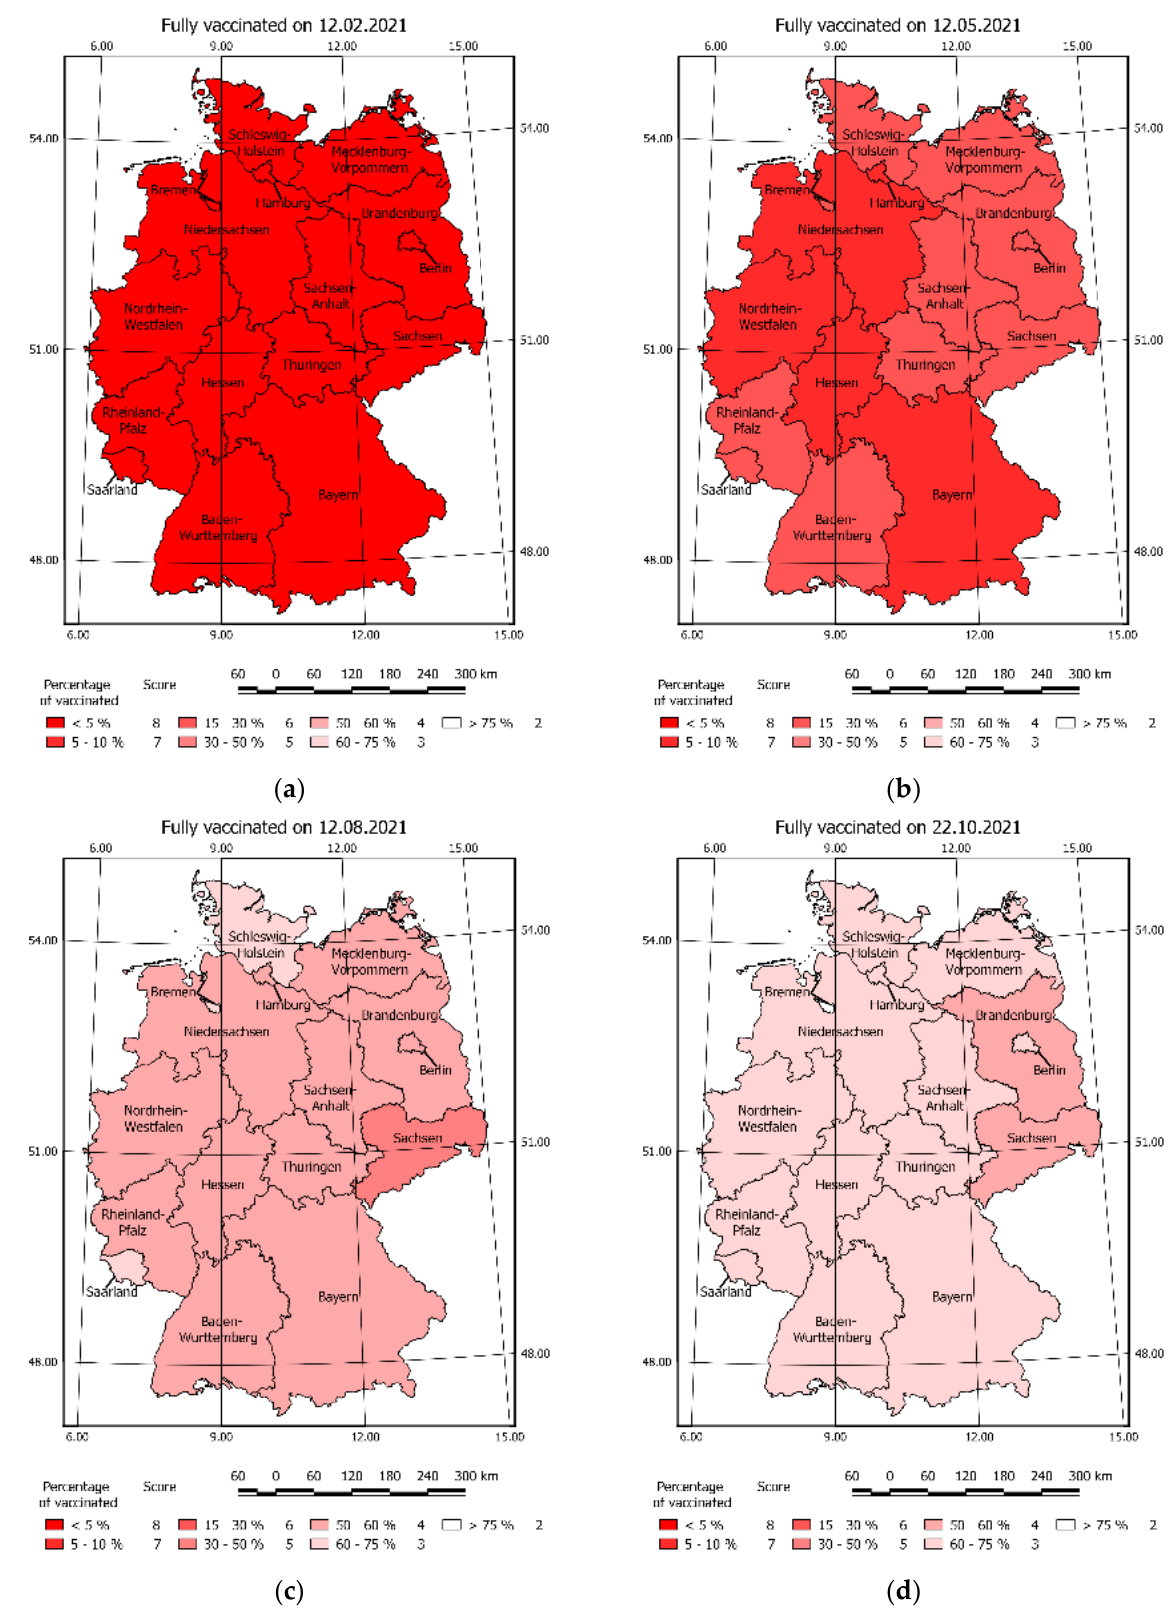
Figure 8. Cumulative COVID-19 Vaccinations on selected days: ( a ) 12 February 2021 ( b ) 12 May 2021 ( c ) 12 August 2021 ( d ) 22 October 2021.